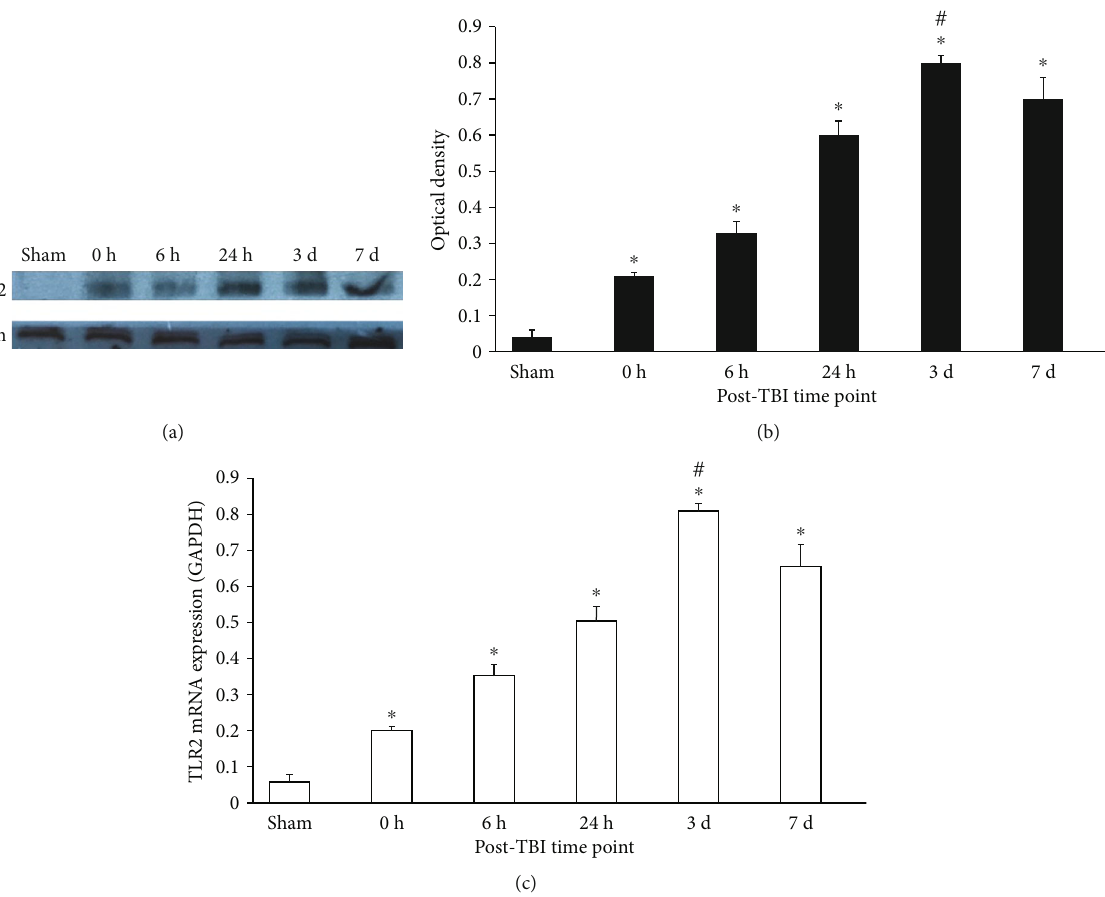
Figure 4: Expression of TLR2 protein and mRNA in the DG (western blotting and PCR). (a) Western blotting: electrophoresis bands of TLR2 protein controlled with β -actin; (b) western blotting: the optical density of TLR2 electrophoresis; (c) real-time PCR: the expression of TLR2 mRNA and GAPDH was used as the endogenous reference gene. The TLR2 expression in the protein and mRNA level was signi fi cantly higher in the TBI group than that in the sham group ( ∗ p < 0 : 05 ), and the TLR2 expression was signi fi cantly di ff erent among various time points ( # p < 0 : 05 ). Data were expressed as mean ± SEM